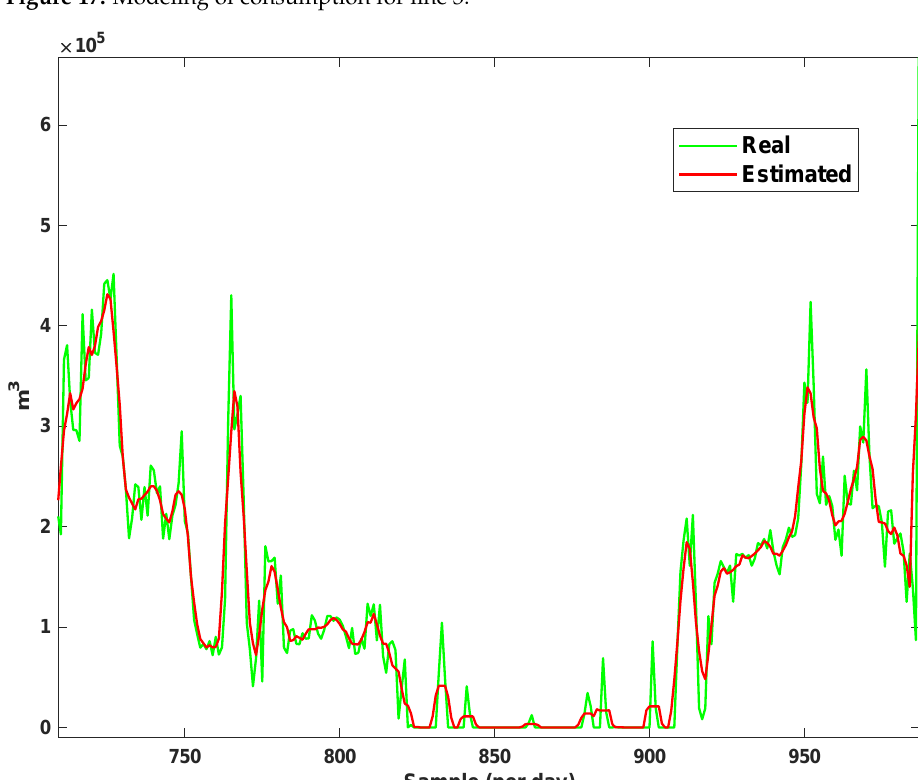
Figure 18. Modeling of consumption for line 3: Zoomed